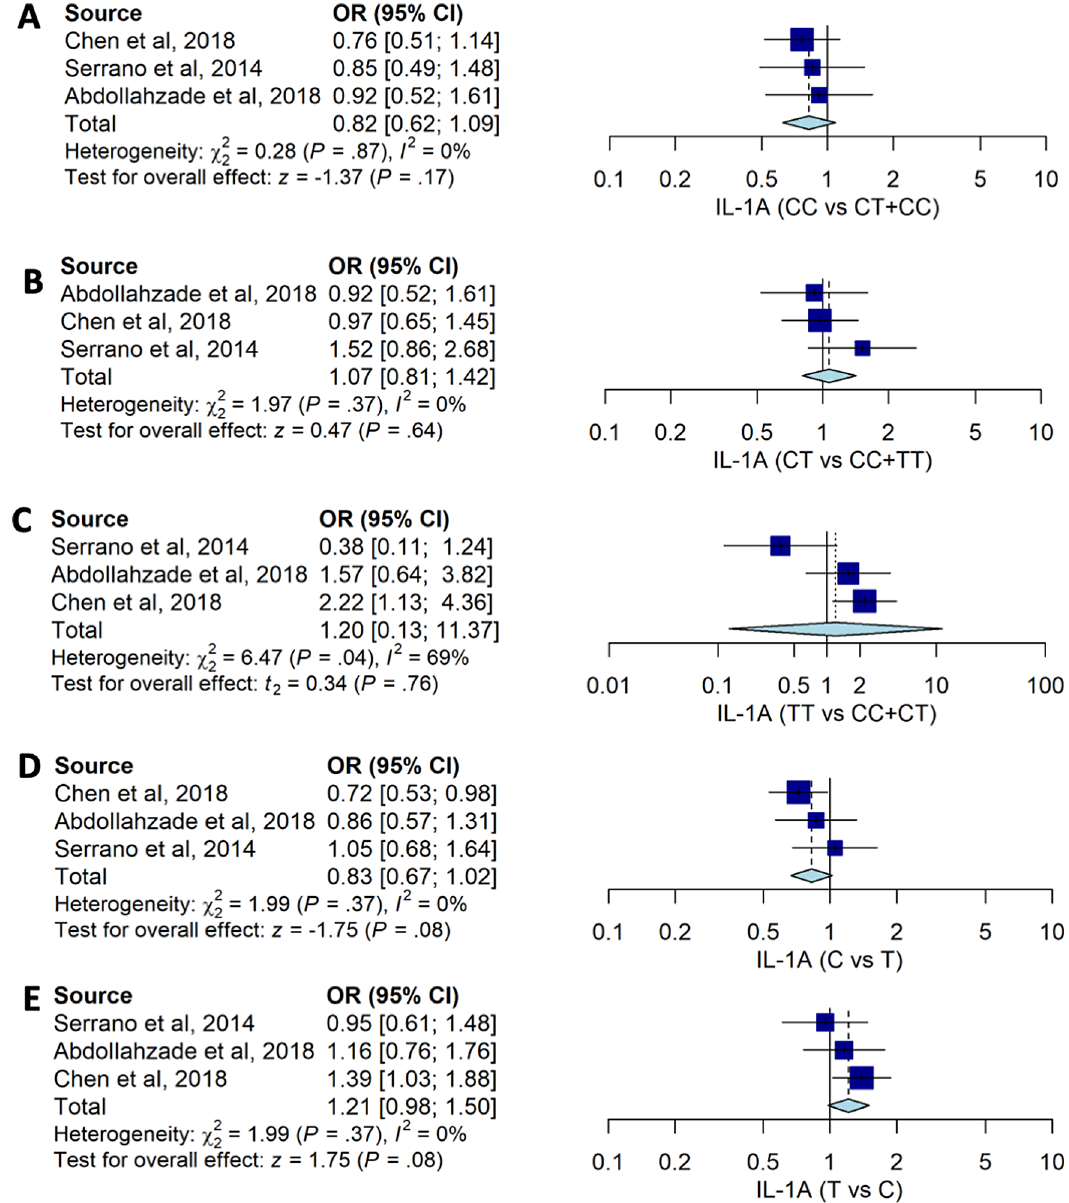
Figure 2. The forest plot of the association of IL-1A -889C>T and HNP. (A) CC vs CT+TT (OR: 0.82; 95%CI: 0.62, 1.09); p-value0.170, p-Het 0.867, and p-Egger 0.193, (B) CT vs CC+TT (OR1.07; CI95%: 0.81, 1.42); p-value 0.637; p-Het 0.373; p-Egger 0.675, (C) TT vs CT+CC (OR: 1.20; CI95%: 0.13, 11.37); p-value 0.764, p-Het 0.039, p-Egger 0.177, (D) C vs T (OR0.83; 95%CI: 0.67, 1.02); p-value 0.081; p-Het 0.369; p-Egger 0.221), and (E) T vs C (OR: 1.21; CI95%: 0.98, 1.50); p-value 0.081; p-Het 0.369; p-Egger